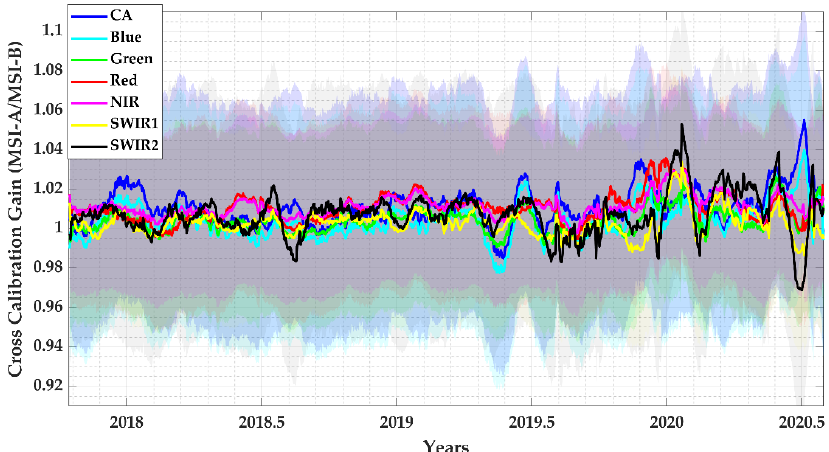
Figure 12. The trend-to-trend cross-calibration gain of Sentinel 2A MSI and Sentinel 2B MSI. The shaded region is the uncertainty for individual bands.